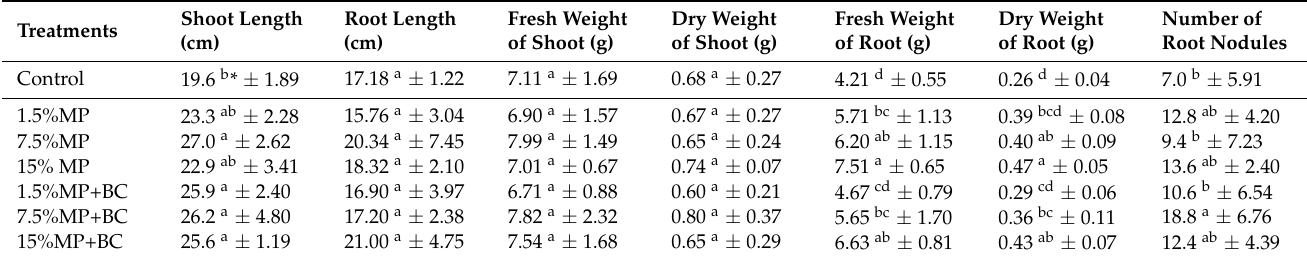
Table 4. Biochar effect on the morphological traits of Vicia faba that affected by microplastic addition to soil.